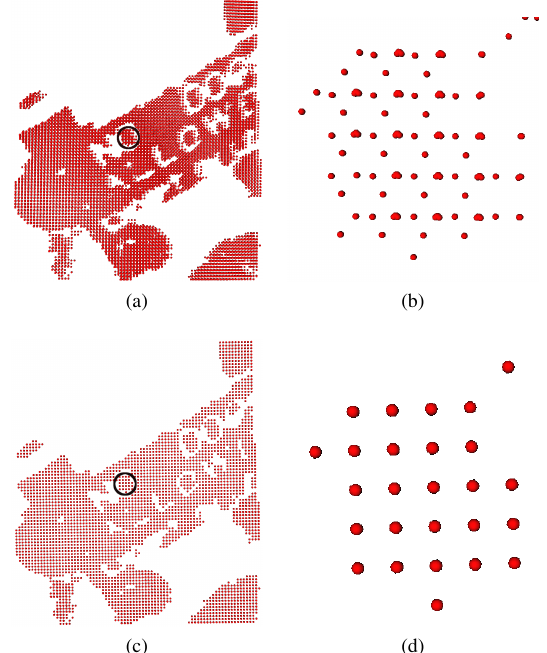
Fig. 20: Zoom-in the selected area showing how the points do not coincide in the ICP-CTSF with k = 50% , producing a blurred image observed in Figure 19b. The same does not happen with the Sparse ICP CTSF with k = 5% . (a) ICP- CTSF k = 50% . (b) Zoon-in the selected region. (c) Sparse ICP CTSF k = 5% . (d) Selected region in